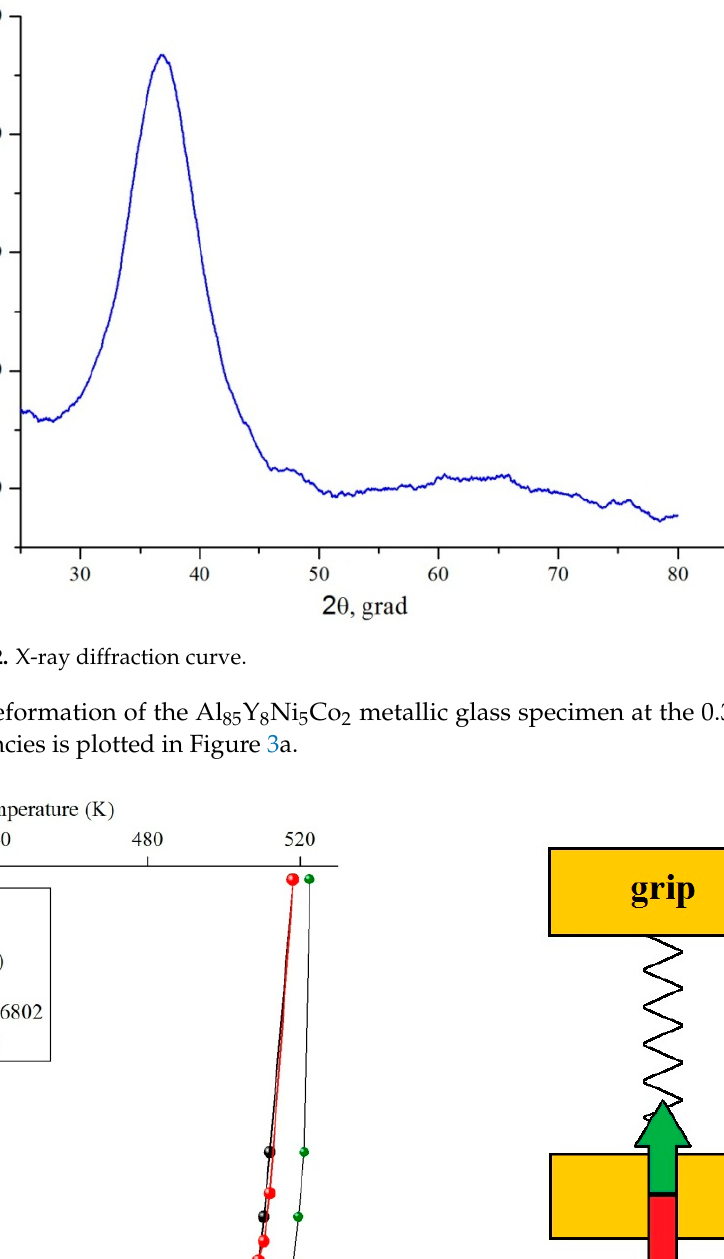
Figure 3 . Experiment and modeling: ( a ) Experimental and analytical relations of the elongation of a specimen from time and temperature; ( b ) Scheme of loading: Loading direction is indicated with the red arrow and the reaction force is de- picted with the green arrow.